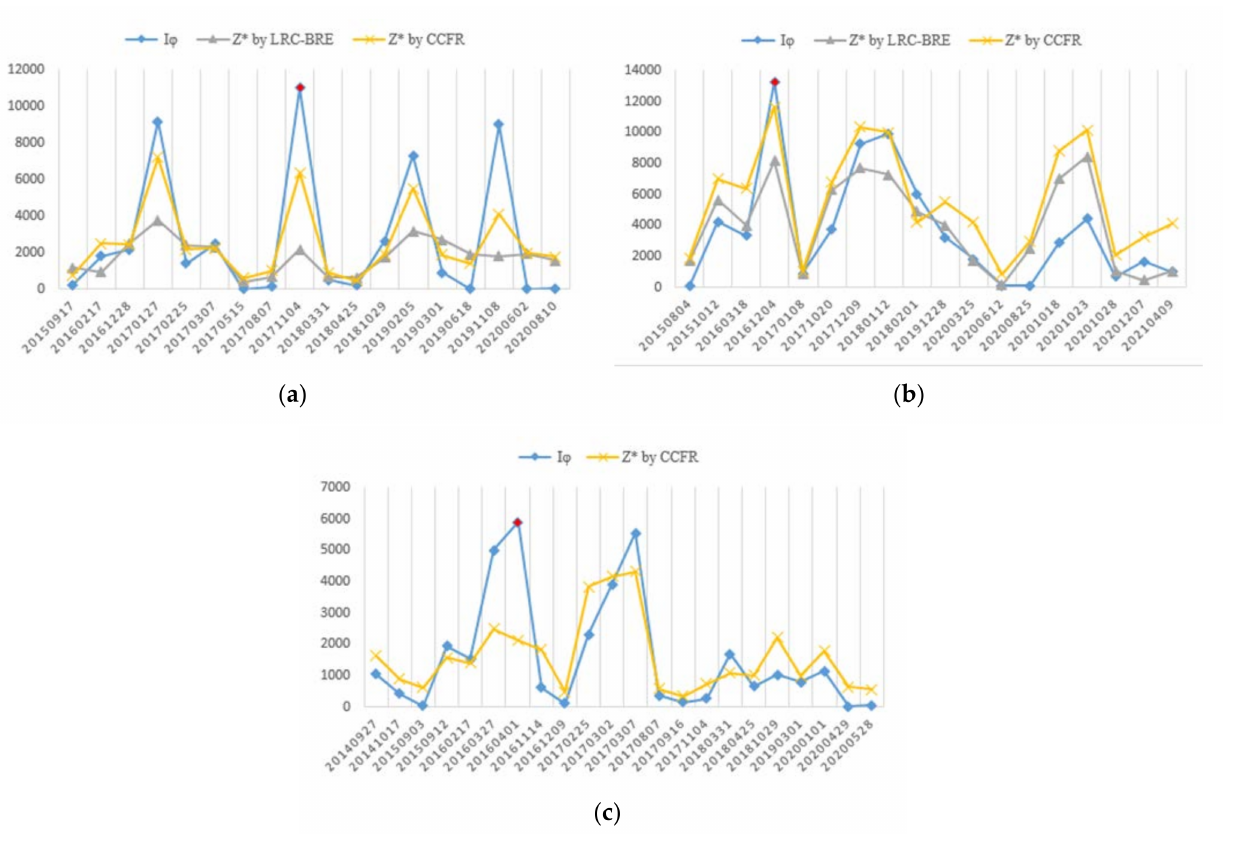
Figure 15. Global multi-temporal image sequence feature matching quantization results in the three experiments. ( a ) Ecological reserve. ( b ) Mine production area. ( c ) Mine environmental treatment area. The abscissa is the imaging date of the sensing image, and the ordinate is the number of feature matching inner points. The blue polyline, gray polyline, and yellow polyline are, respectively, the number of feature matching inner points with the lowest outlier image I ϕ , the stable feature image Z ∗ L extracted by LRC-BRE, and the stable feature image Z ∗ C extracted by i i